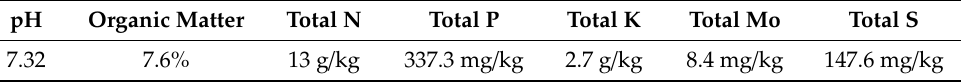
Table 1. Physicochemical properties of the soil used in the present